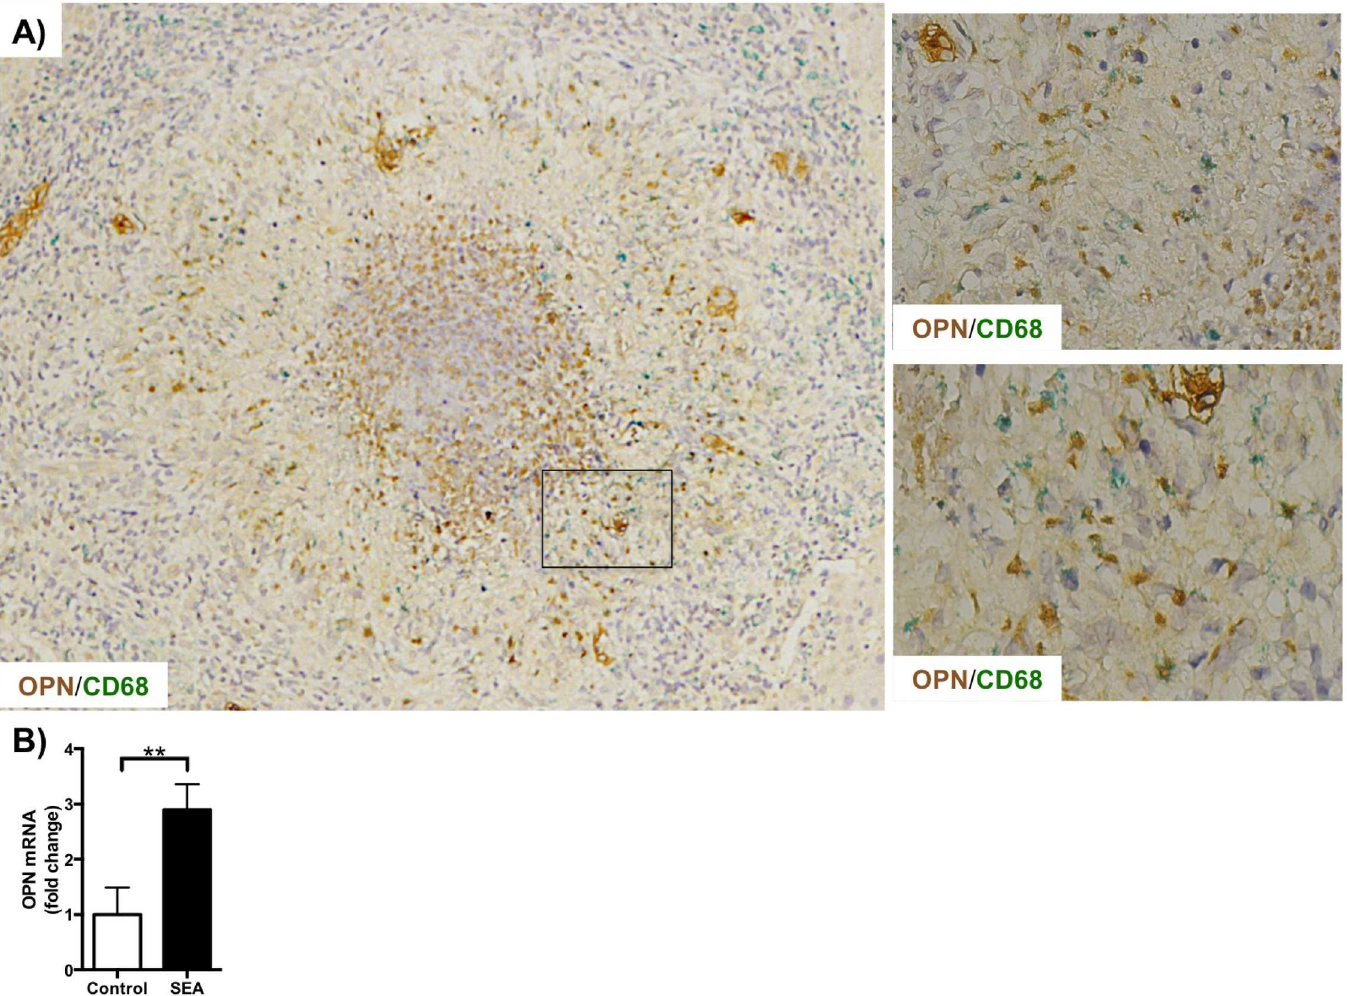
Fig 3. Soluble egg antigens induce Osteopontin expression in primary human Kupffer cells. A) Double Immunohistochemistry for osteopontin (OPN, brown) and CD68 (macrophage marker, green) in liver needlebiopsy fragment of a representative subject with acute schistosomiasis mansoni (10 weeks post infection, same case depicted in Fig 1D) demonstrating that macrophagesexpress osteopontin in human acute schistosomiasis mansoni. The rectangle highlightsthe magnifiedarea shown on the 2 pannelson the right. Final magnification 100x (left), 400x (upper right) and 600x (lower right). B) Osteopontin mRNA expression (fold change) in primary human Kupffer cells incubated with 10 μ g/ml SEA or 0.0001 μ g/ml LPS (lipopolysaccharide; control, same amount of endotoxinpresent in the SEA preparation) after 3 hours of incubation.Mean ± SEMare displayed, Student’s t test: * p < 0.05, ** p < 0.01, *** p < 0.001, **** p <